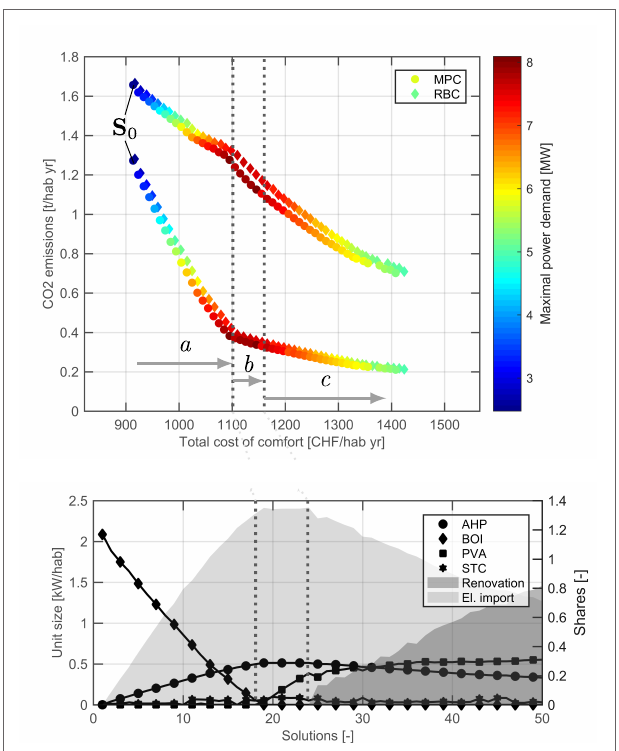
FIGURE 12 | Pareto fronts for Switzerland when applying MPC (circles) and RBC (diamonds). The marker size reflects the renovation share of the current built environment.